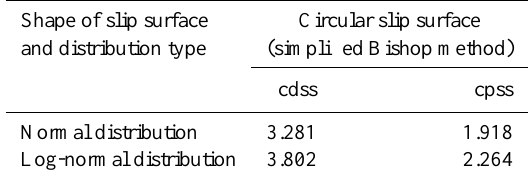
Table 8. Summary of reliability indices for example 3 in Fig. 13. Shape of slip surface Circular slip surface and distribution type